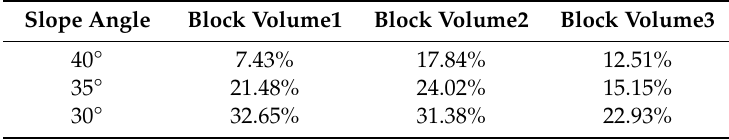
Table 4. Peak impact force reduction caused by the cushioning e ff ect of the dead